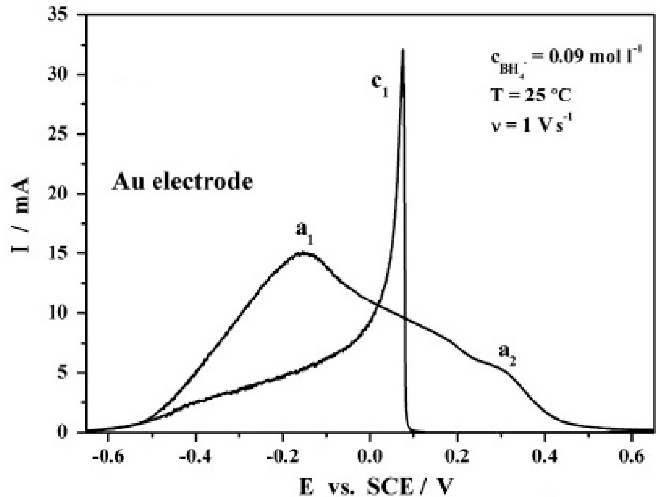
Figure 1. Cyclic voltammetry 1 V s − 1 on Au electrode in 2 M NaOH + 0.09 M NaBH 4 solution at 25 °C. Reproduced from ref. [32] with permission from the publisher.